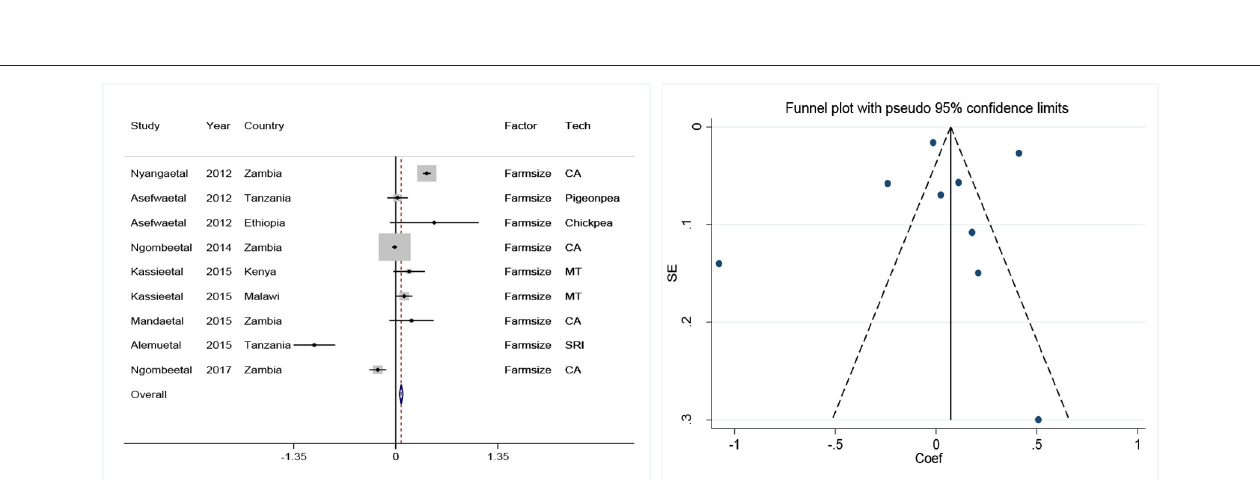
FIGURE 2 | The effects of access to credit on the adoption of various CSA practices in parts of eastern and southern Africa. Source: Computed from Asfaw et al. (2012), Nyanga (2012), Teklewold et al. (2013), and Ng’ombe et al. (2017). The horizontal lines in the forest plots are the confidence intervals (CIs) and the gray areas are study weights generated in the meta function. The dotted vertical line in the left panel shows the overall/combined effects. CIs that cross the zero line indicate statistical insignificance, while those on the left (right) show statistically significant negative (positive) effects. CSA denotes combined technologies.